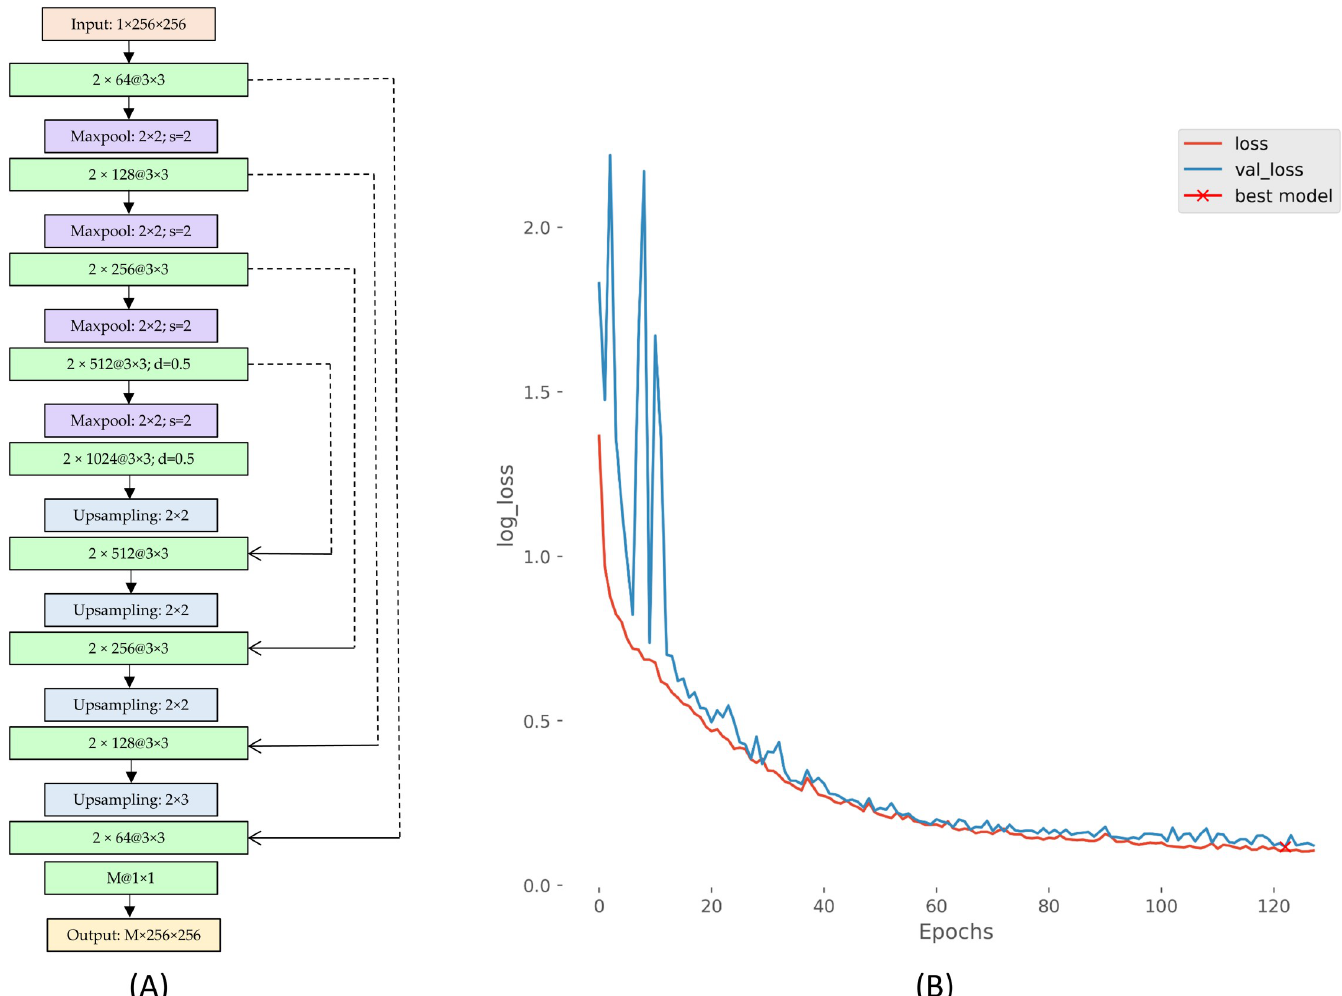
Fig 1. The architecture of the custom U-Net with dropout and its performance curves.